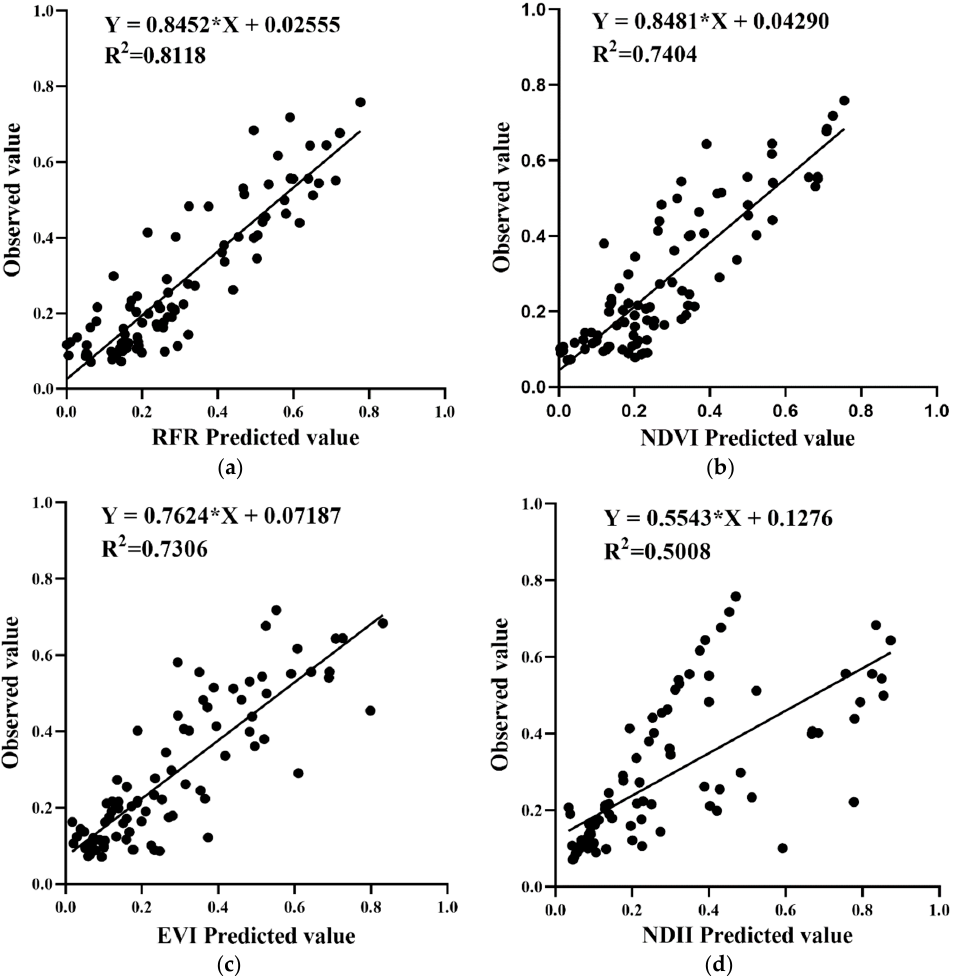
Figure 6. The comparisons between detected and observed forest damage severity (0–1) based